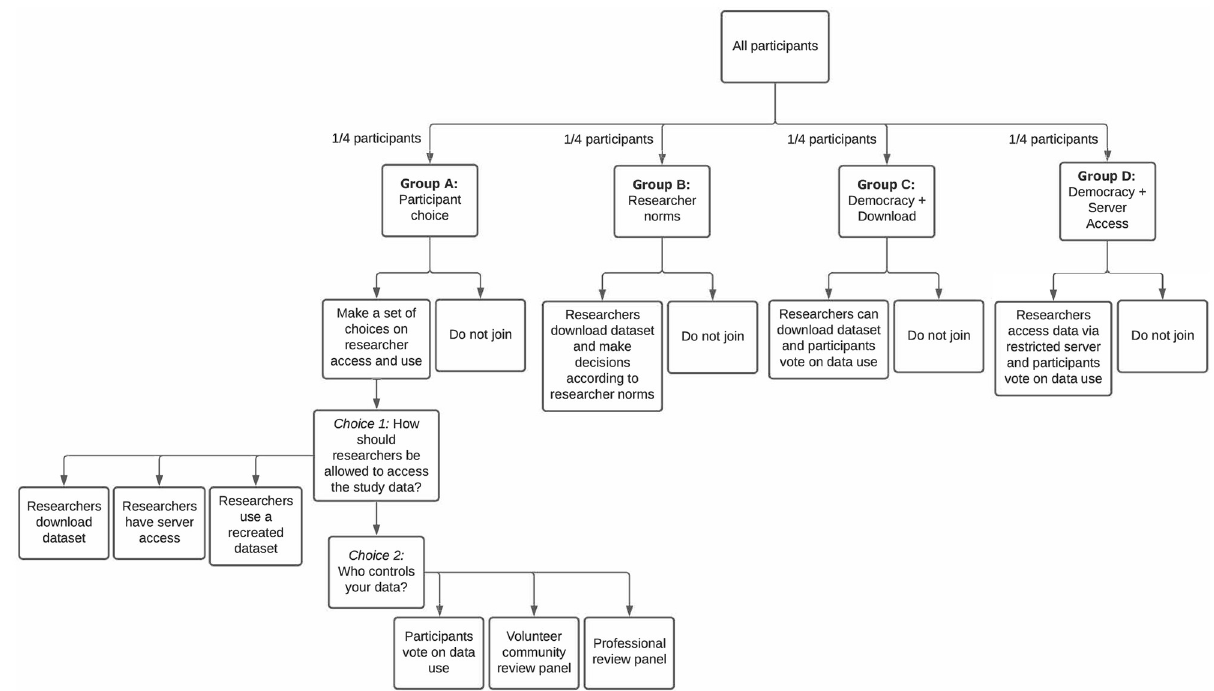
Fig 2. Quantitative study